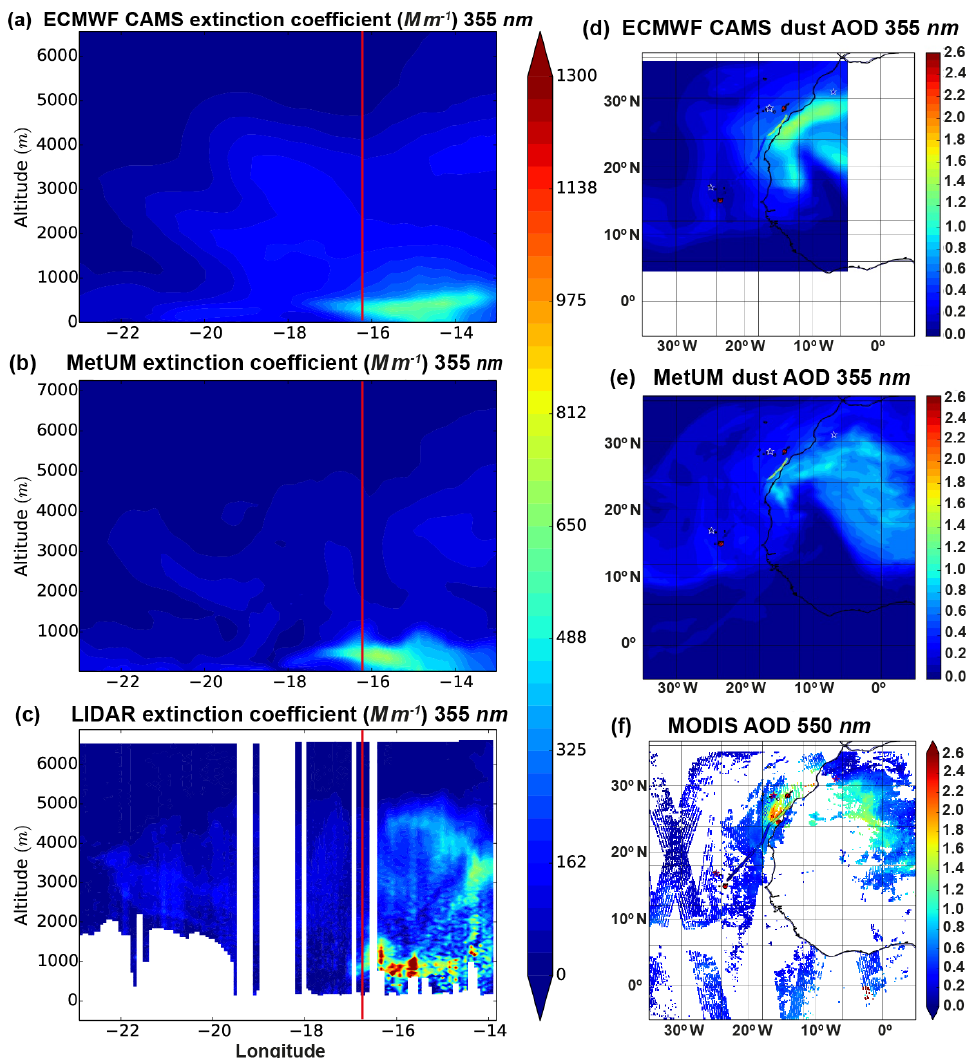
Figure 9. Case study 2, B923, 12 August, R1: (a–c) vertical cross section along the flight track showing the aerosol extinction coefficient for ECMWF–CAMS (a) , MetUM (b) , and the aircraft lidar (c) ; the colour scale is the same for all three plots. (d) ECMWF–CAMS AOD map, (e) MetUM AOD map, and (f) AOD map from combined observations from MODIS, AERONET (stars), and aircraft lidar